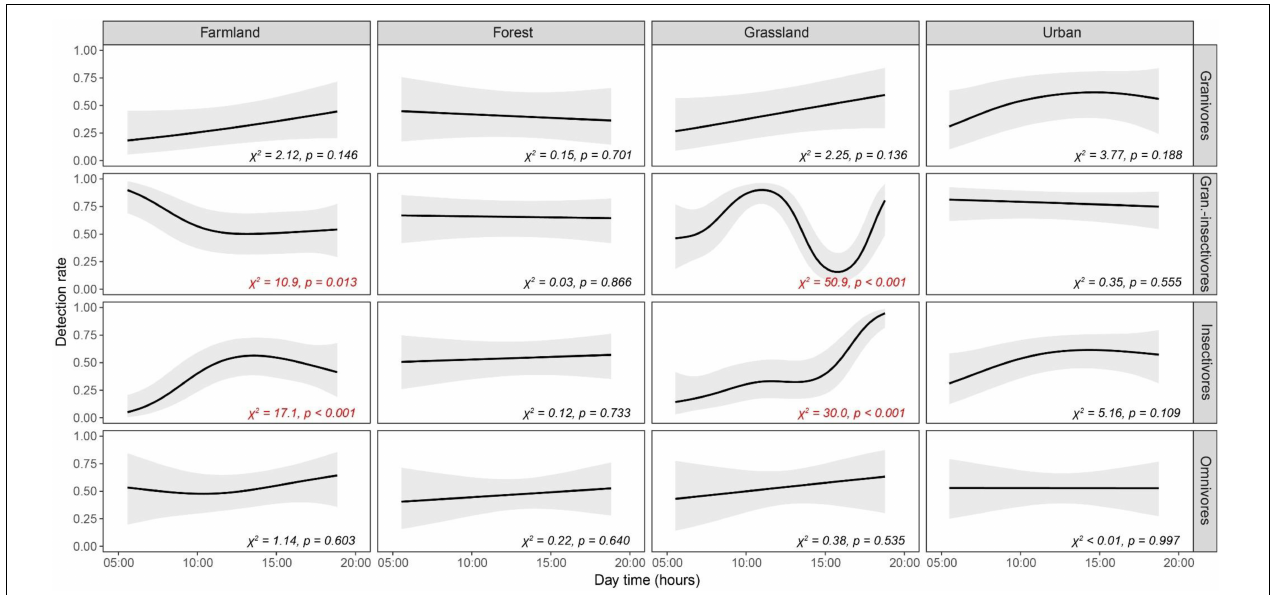
FIGURE 3 | Temporal patterns of detection rates of birds of four trophic guilds (granivores, granivores-insectivores, insectivores and omnivores) in four habitats (farmlands, forests, grasslands and urban areas) as modeled by GAMMs. Predicted detection rates (lines) are displayed along with 95% confidence bands (gray envelopes), keeping other variables constant at their mean values. Wald tests statistics ( χ 2 ) and associated probabilities (p) are given for each relationship. Results significant at α = 5% are highlighted in